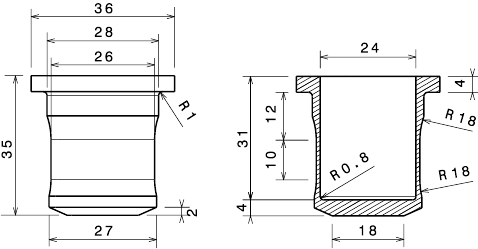
Figure 12. The geometry of the target for the dynamic tensile test.